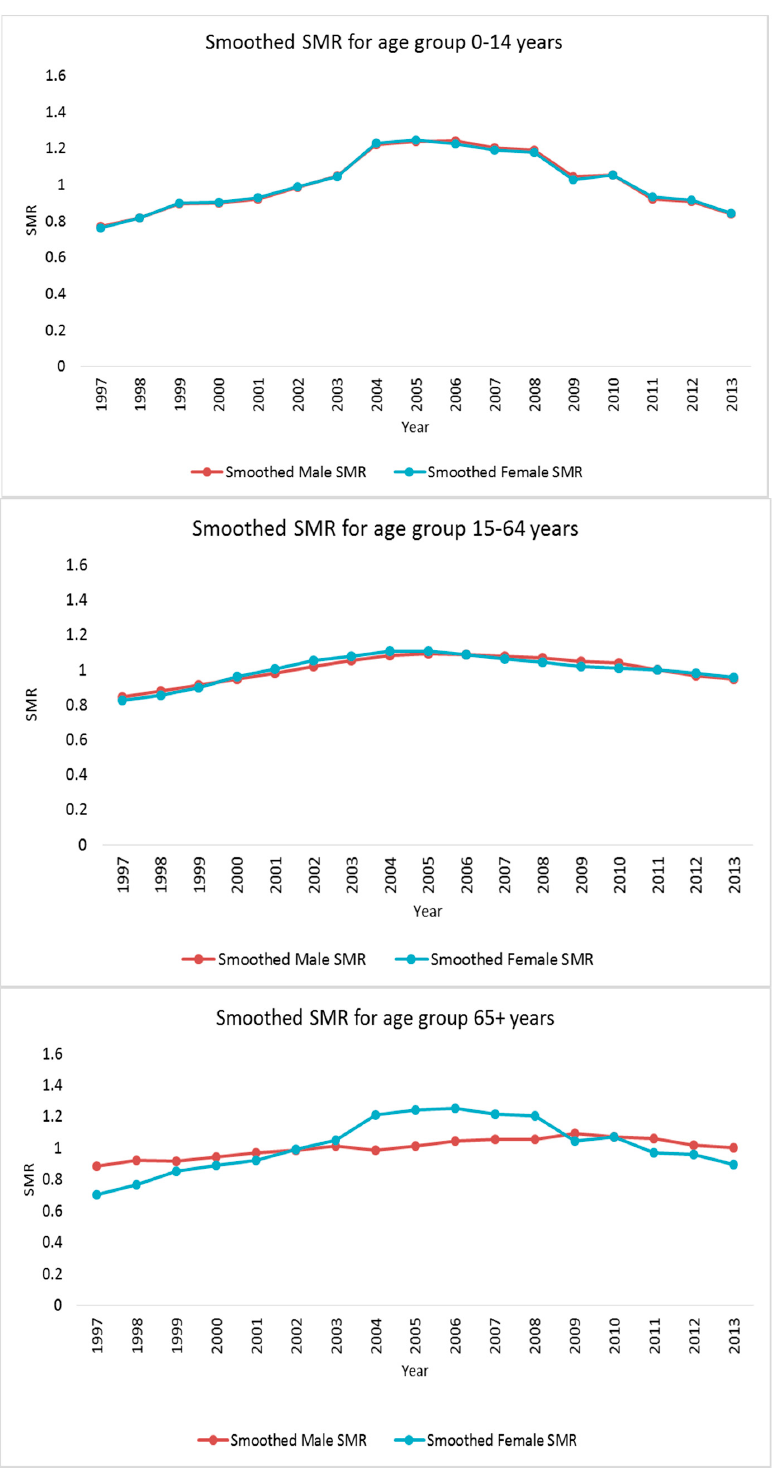
Figure 1. Overall time series plots of the raw and posterior median smoothed standardized mortality rate ratios (SMRs) for males and females within each of the three age bands.